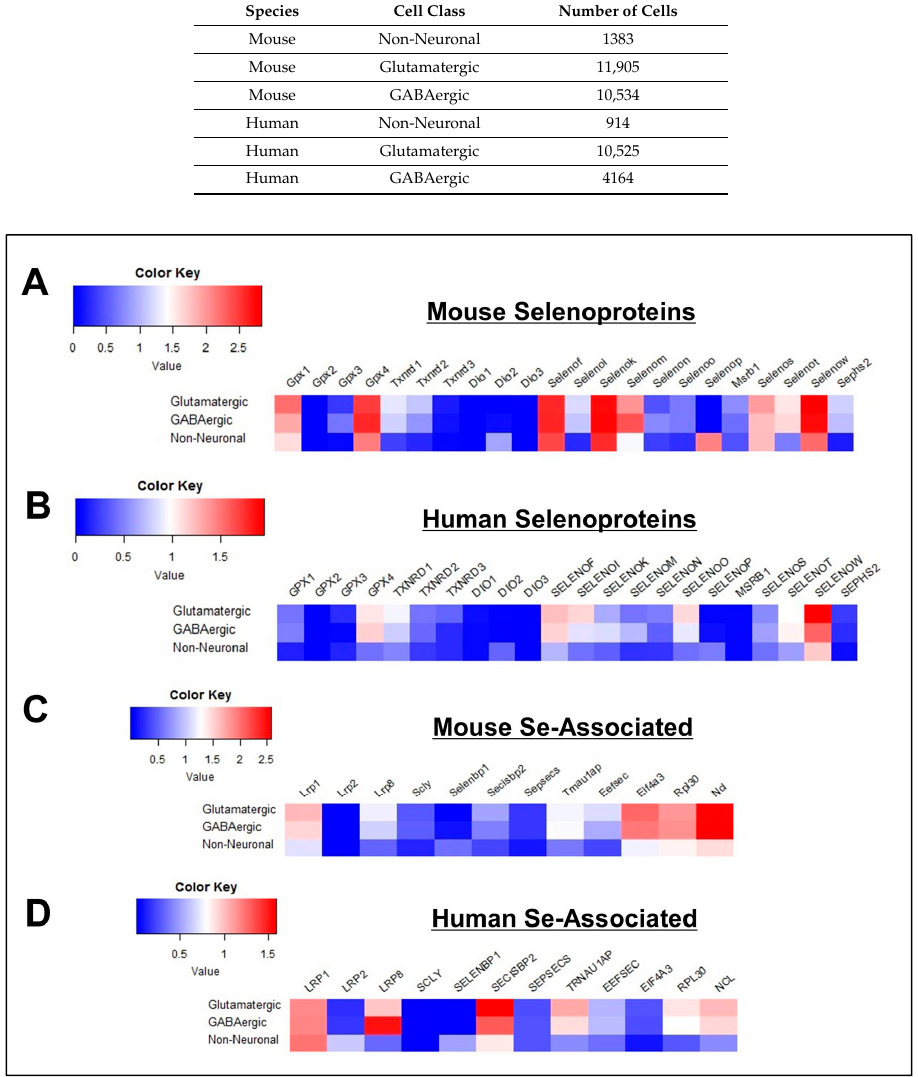
Figure 1. General profile of Se-Related Transcriptome in Cortical Cells. ( A , B ) Heatmaps detailing expression of mouse ( A ) and human ( B ) selenoprotein genes in glutamatergic, GABAergic, and non-neuronal cells. ( C , D ) Corresponding heatmaps of mouse ( C ) and human ( D ) Se-associated